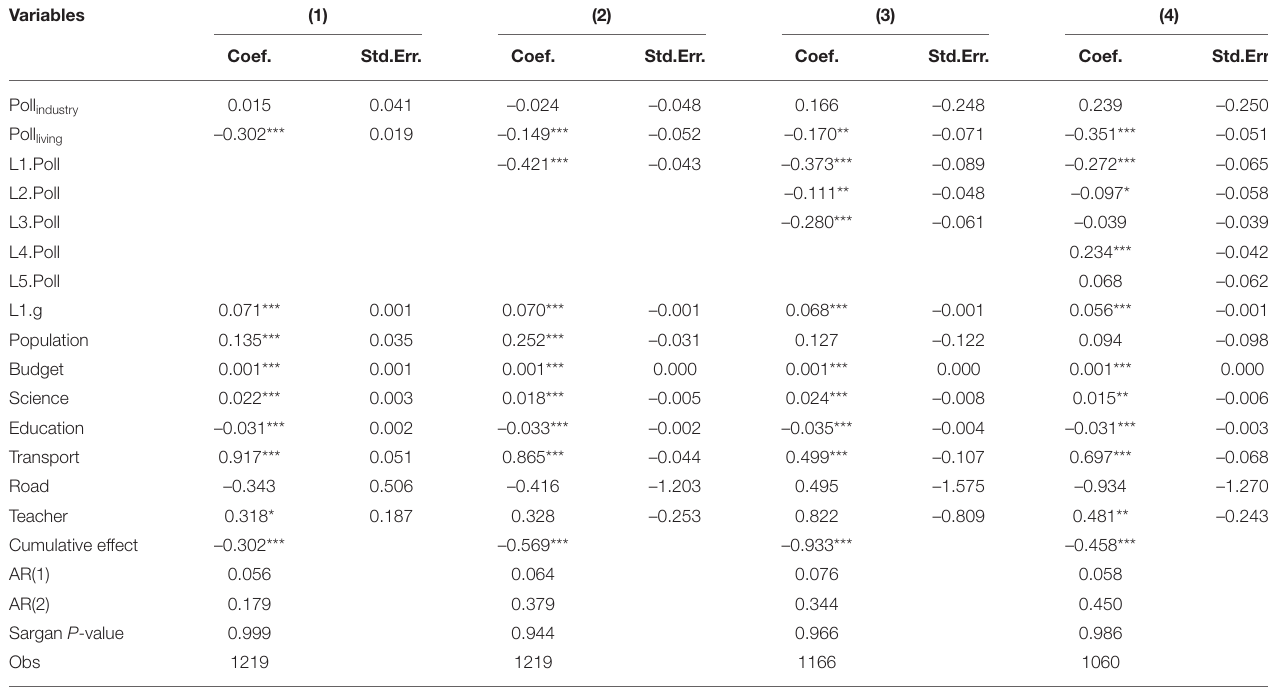
TABLE 7 | Results of dynamic estimation of the impact of domestic sewage discharges on the volume of output